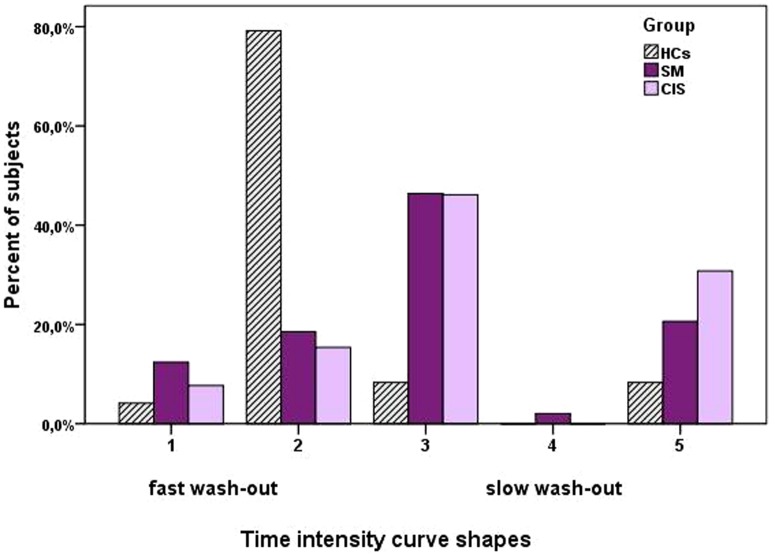
Frequency of Time intensity curve shapes in the different groups of subjects.The curve shapes 1-2 corresponds to a fast wash-out. The curve shapes 3-5 corresponds to slow wash-out.